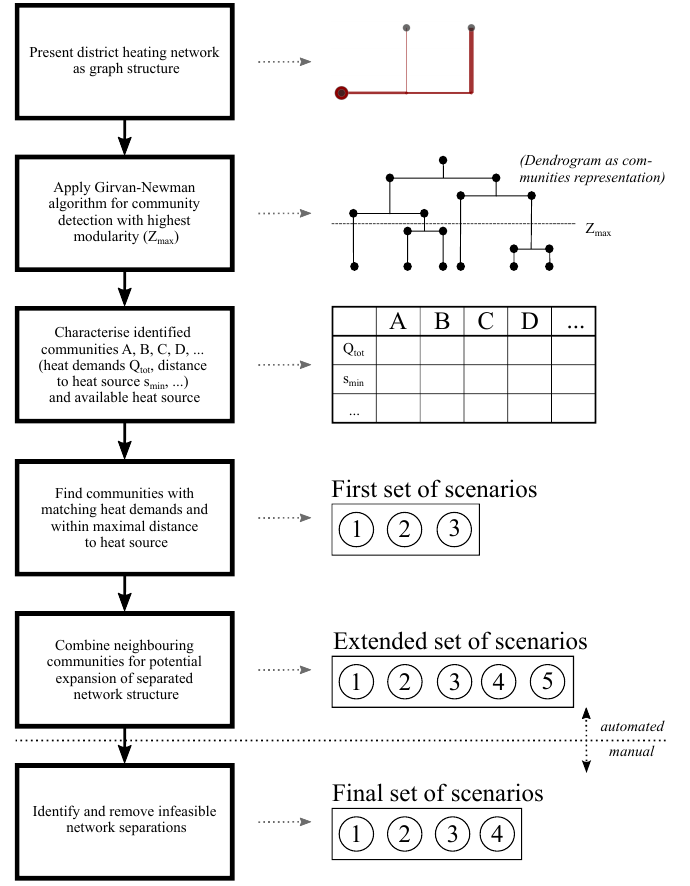
Figure 2. Framework for identifying possible network separations of a district heating network. Network as Graph